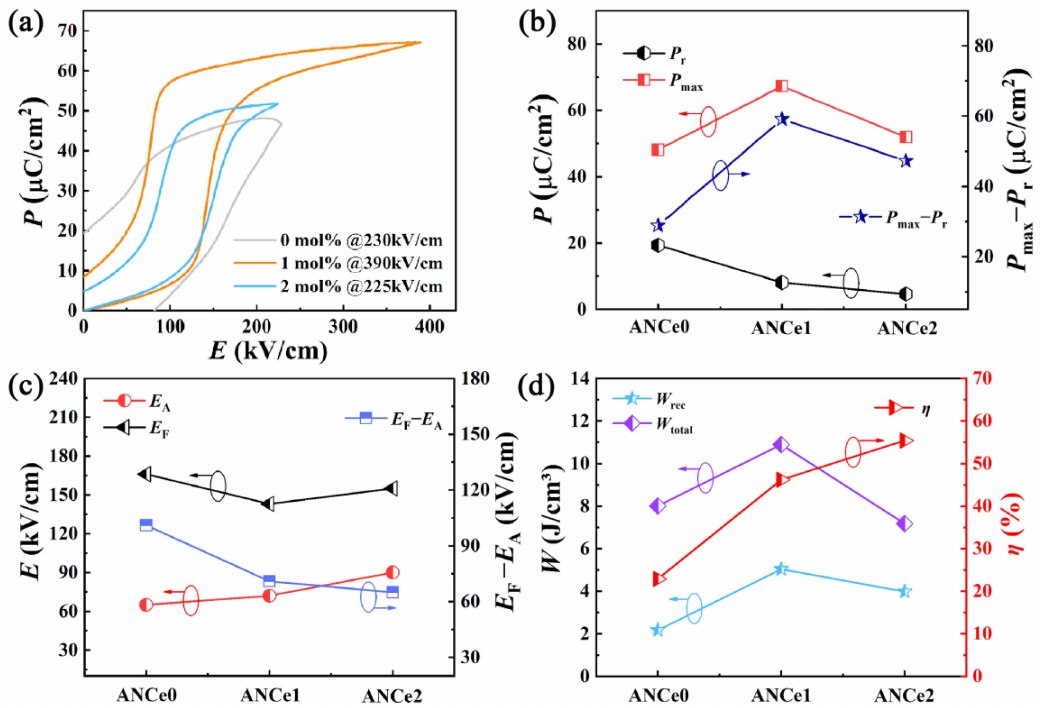
Figure 6. Energy storage properties of ANCe x ceramics. ( a ) Unipolar P - E loops, ( b ) P max , P r and P max − P r , (The red and black circles and arrows point to the P axis, and the blue circles and arrows point to the P max − P r axis.) ( c ) E A , E F and E A − E F , (The red and black circles and arrows point to the E axis, and the blue circles and arrows point to the E F − E A axis.) and ( d ) W total , W rec and η . ((The purple and blue circles and arrows point to the W axis, and the red circles and arrows point to the η